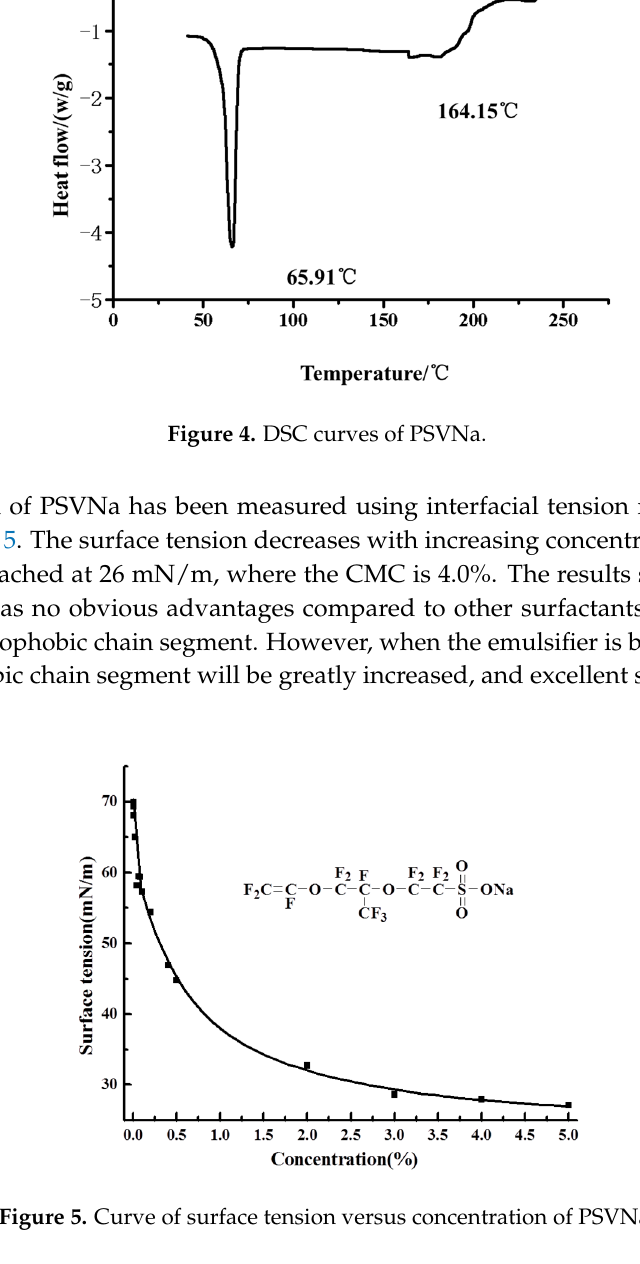
Figure 5. Curve of surface tension versus concentration of PSVNa.